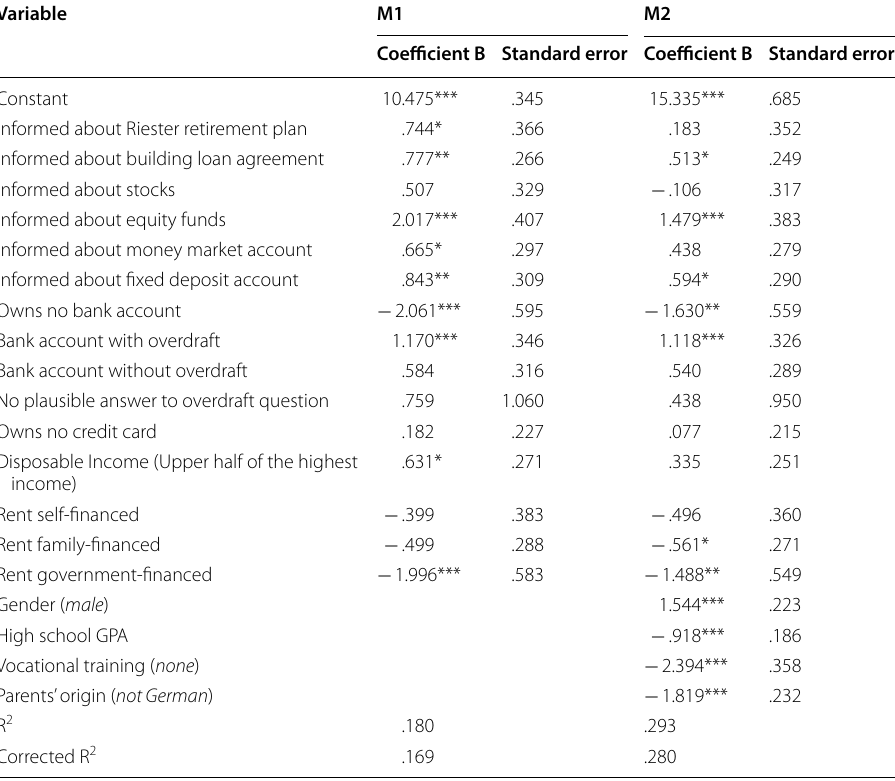
Table 5 Multiple linear regressions on the score in